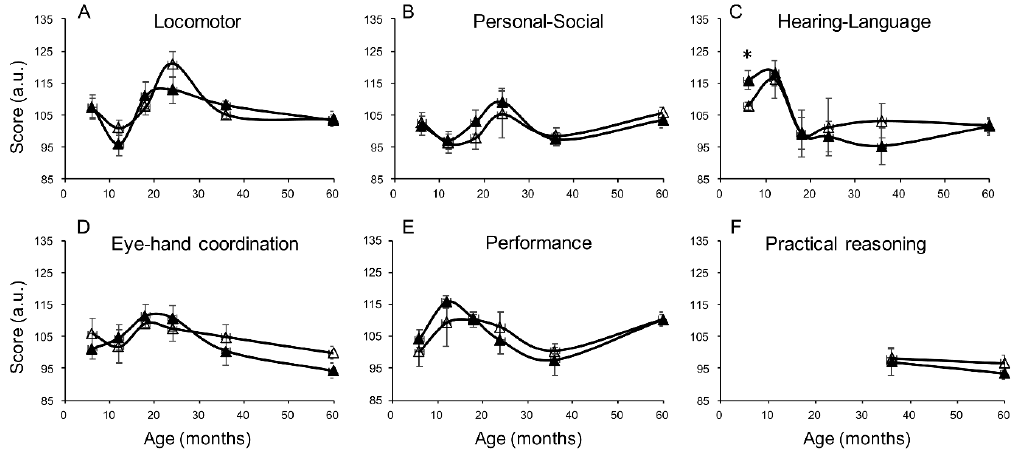
Figure 2. Cognitive development measured in the six cognitive domains ( A – F ) in exclusively breastfed (closed triangles) and nonexclusively breastfed (open triangles) boys at different ages (6, 12, 18, 24, 36, 60 months). N = 15, 16, 12, 13, 14, 30 at progressive ages. Practical reasoning skills are measured from the age of 36 months. Data are represented as mean ± sem. * p ≤ 0.05.